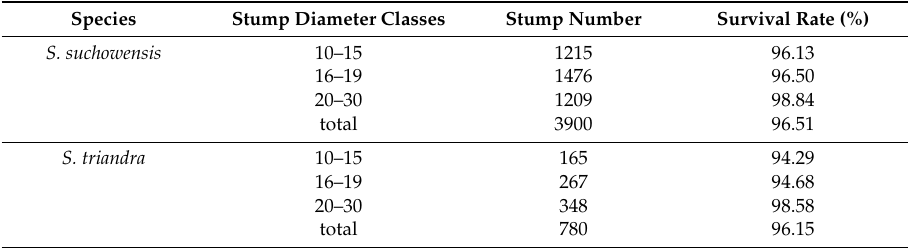
Table 1. Number and the survival rate of di ff erent stump species and diameter